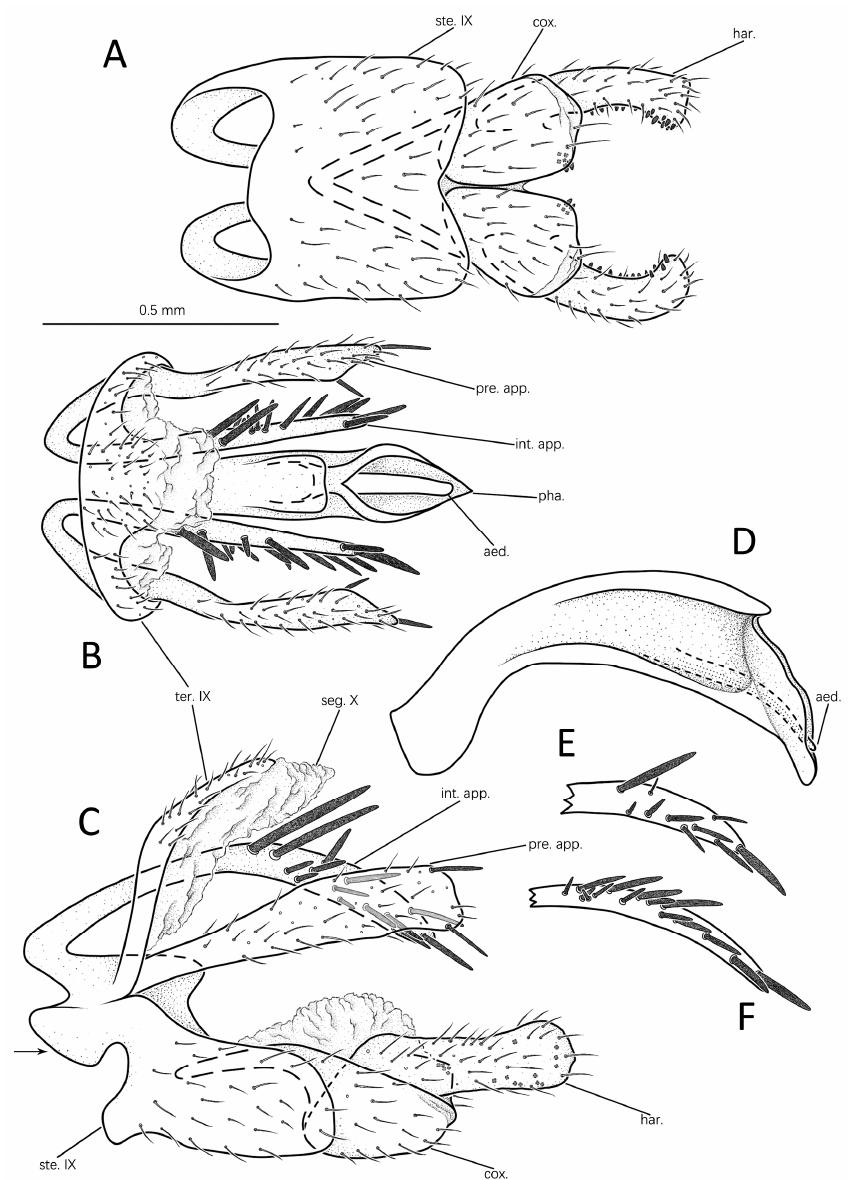
Figure 5. Male genitalia of Eoneureclipsis spinosus sp. nov.: ( A ) ventral; ( B ) dorsal; ( C ) left lateral; ( D ) phallic apparatus, left lateral; ( E ) intermediate appendages of paratype (Guangxi), left lateral; ( F ) intermediate appendages of paratype (Guangdong), left lateral. Abbreviations: ste. IX = sternum IX; ter. IX = tergum IX; seg. X = segment X; pre. app. = preanal appendages (paired); int. app. = intermediate appendages (paired); cox. = coxopodite (paired); har. = harpago (paired); pha. = phallic apparatus; aed. = aedeagus. Scale bar refers to A–F.